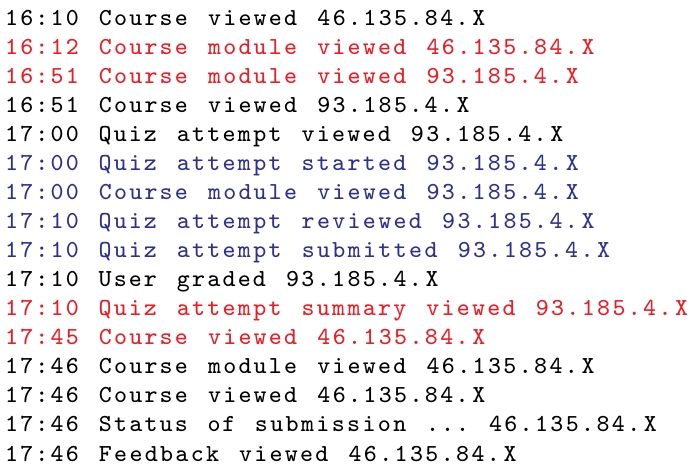
Figure 13. Example of an exam session (selected part) with indicated cheating. Indication events occurred before and after the